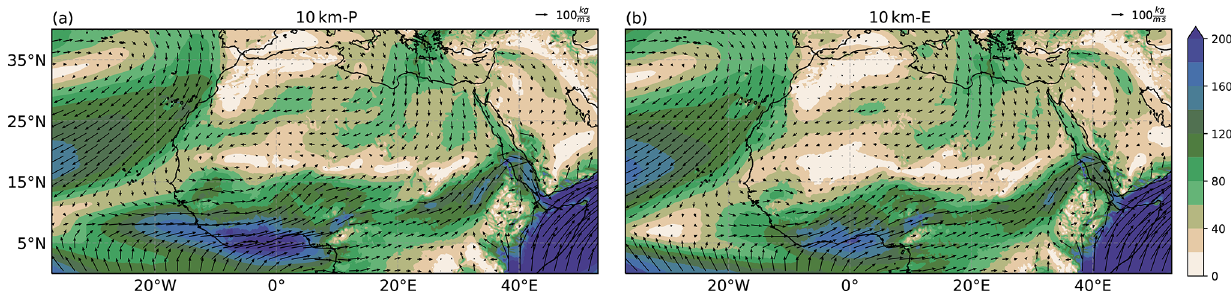
Figure A4. The same as Fig. 9 but for the 10km-P and 10km-E simulations.